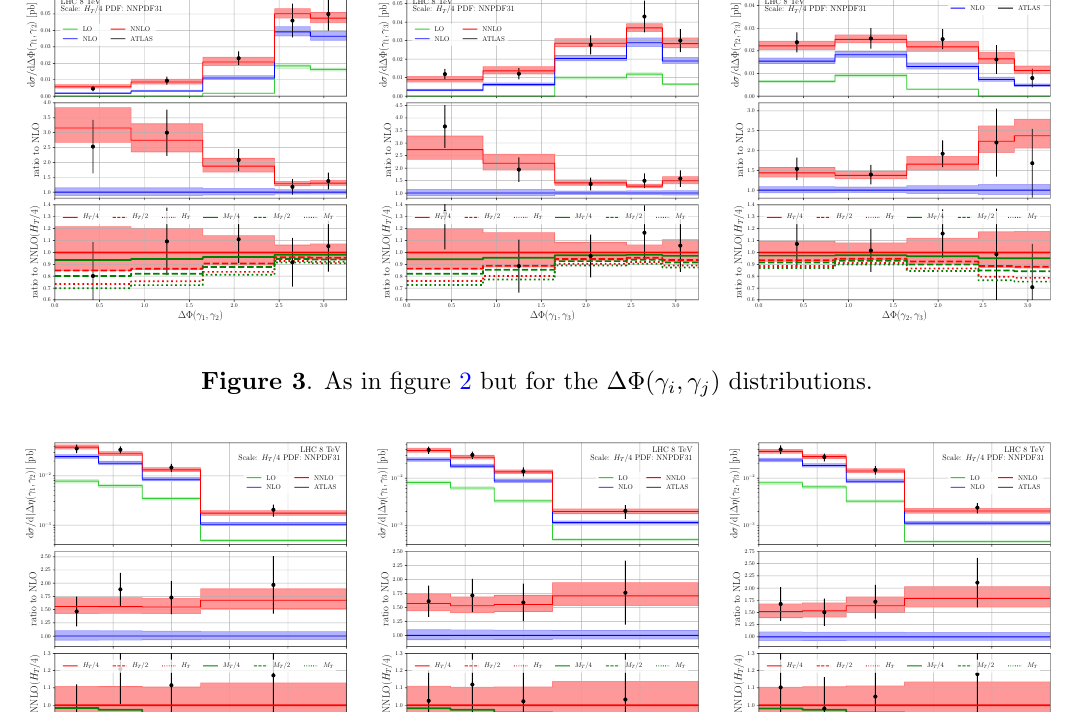
(cid:1) (cid:17) ( (cid:13) i ; (cid:13) j ) j j